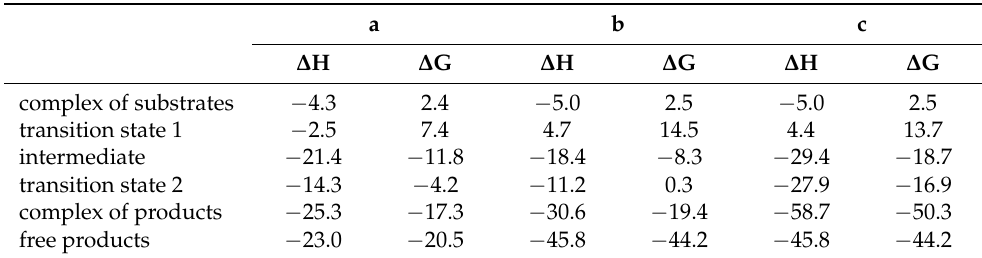
Table 6. Free energies relative to the sum of the free energies of free substrates for the reaction of trans - 6 ( F ) with OH −